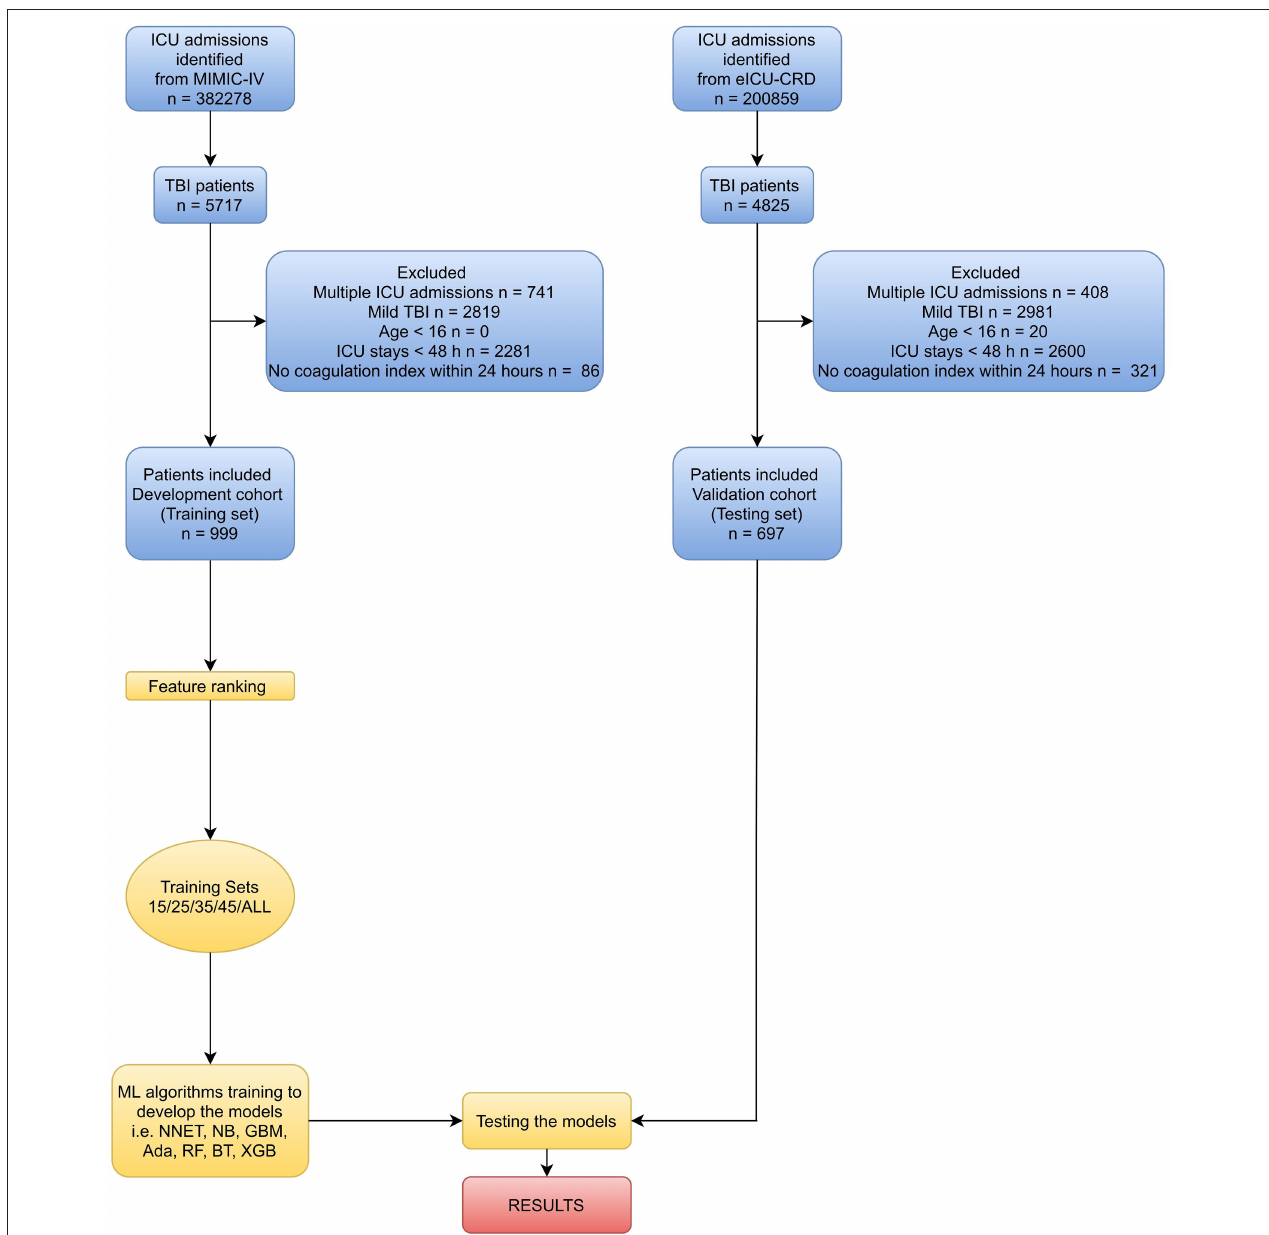
FIGURE 1 | Overview of the methods used for data extraction, training, and testing. ICU, intensive care unit; MIMIC-IV, Medical Information Mart for Intensive Care-IV; eICU-CRD, eICU Collaborative Research Database; TBI, traumatic brain injury; ML, machine learning; NNET, artificial neural network; NB, naïve bayes; GBM, gradient boosting machine; Ada, adapting boosting; RF, random forest; BT, bagged trees; XGB, eXtreme Gradient Boosting.